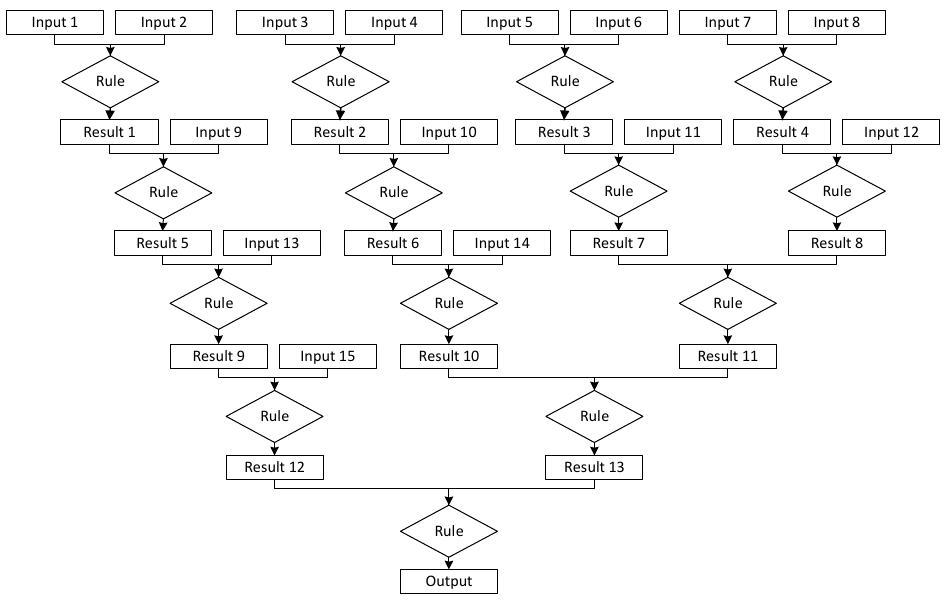
Figure 1. Logical design of Network 1.